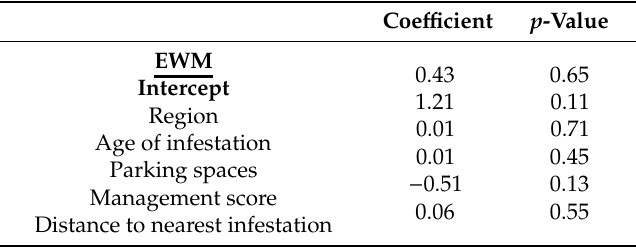
Table 6. Logistic regression analysis (LRA) assessment of Eurasian (EWM), hybrid (HWM), and northern watermilfoil (NWM) presence-absence based on infestation-associated variables. Output includes the model intercept and coe ffi cient and p -value associated with each